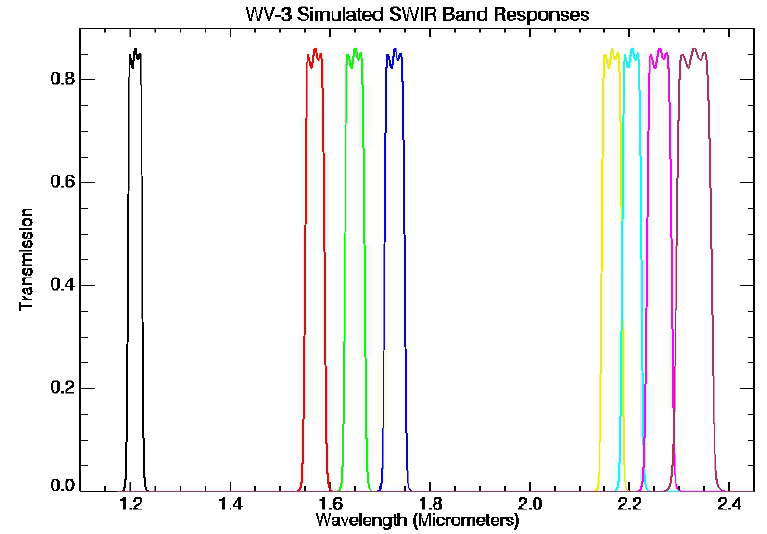
Figure 1. Filter functions provided by DigitalGlobe for the proposed WV-3 Short-Wave-Infrared (SWIR) spectral